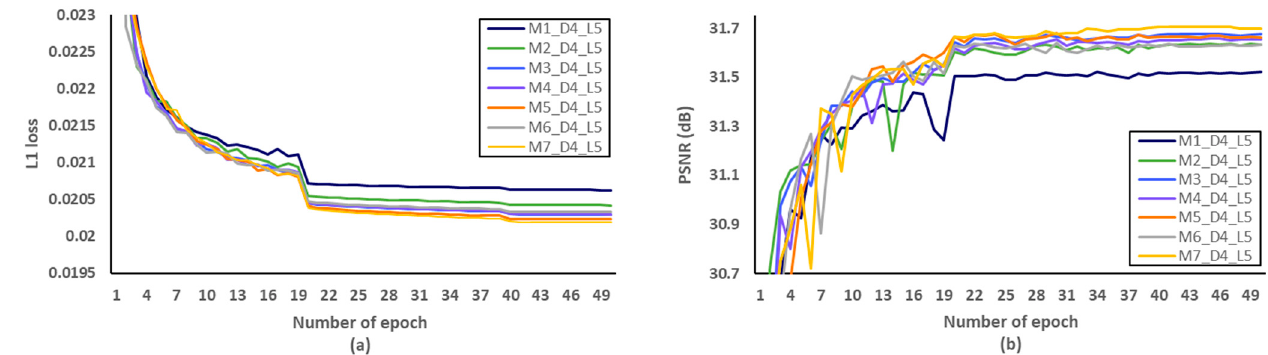
Sensors 2021 , 21 , x FOR PEER REVIEW 14 of 18